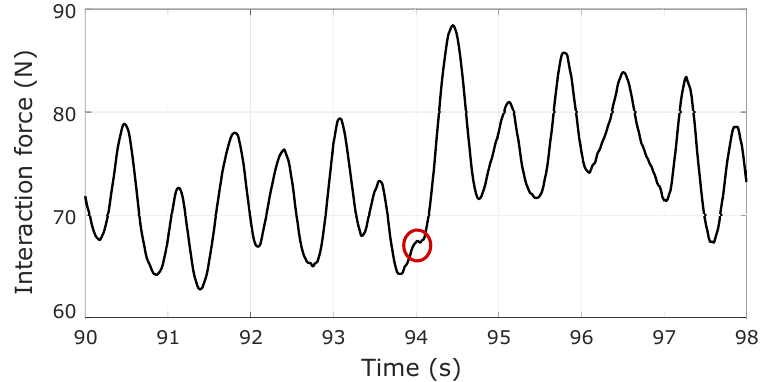
Figure 10. Interaction force under HS misdetection (red